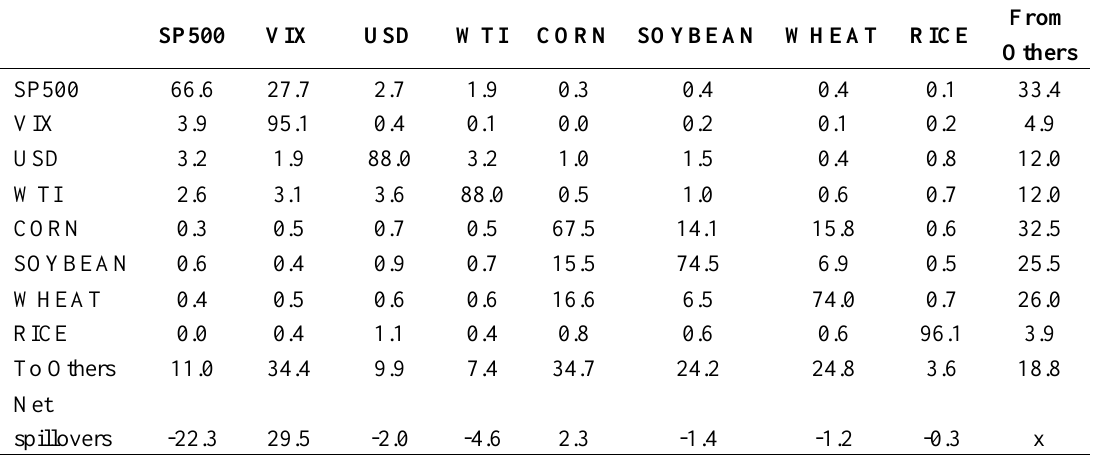
Table 2A: The direction of implied volatility spillovers, VIX included (the lasso method). SP500 VIX USD WTI CORN SOYBEAN WHEAT RICE